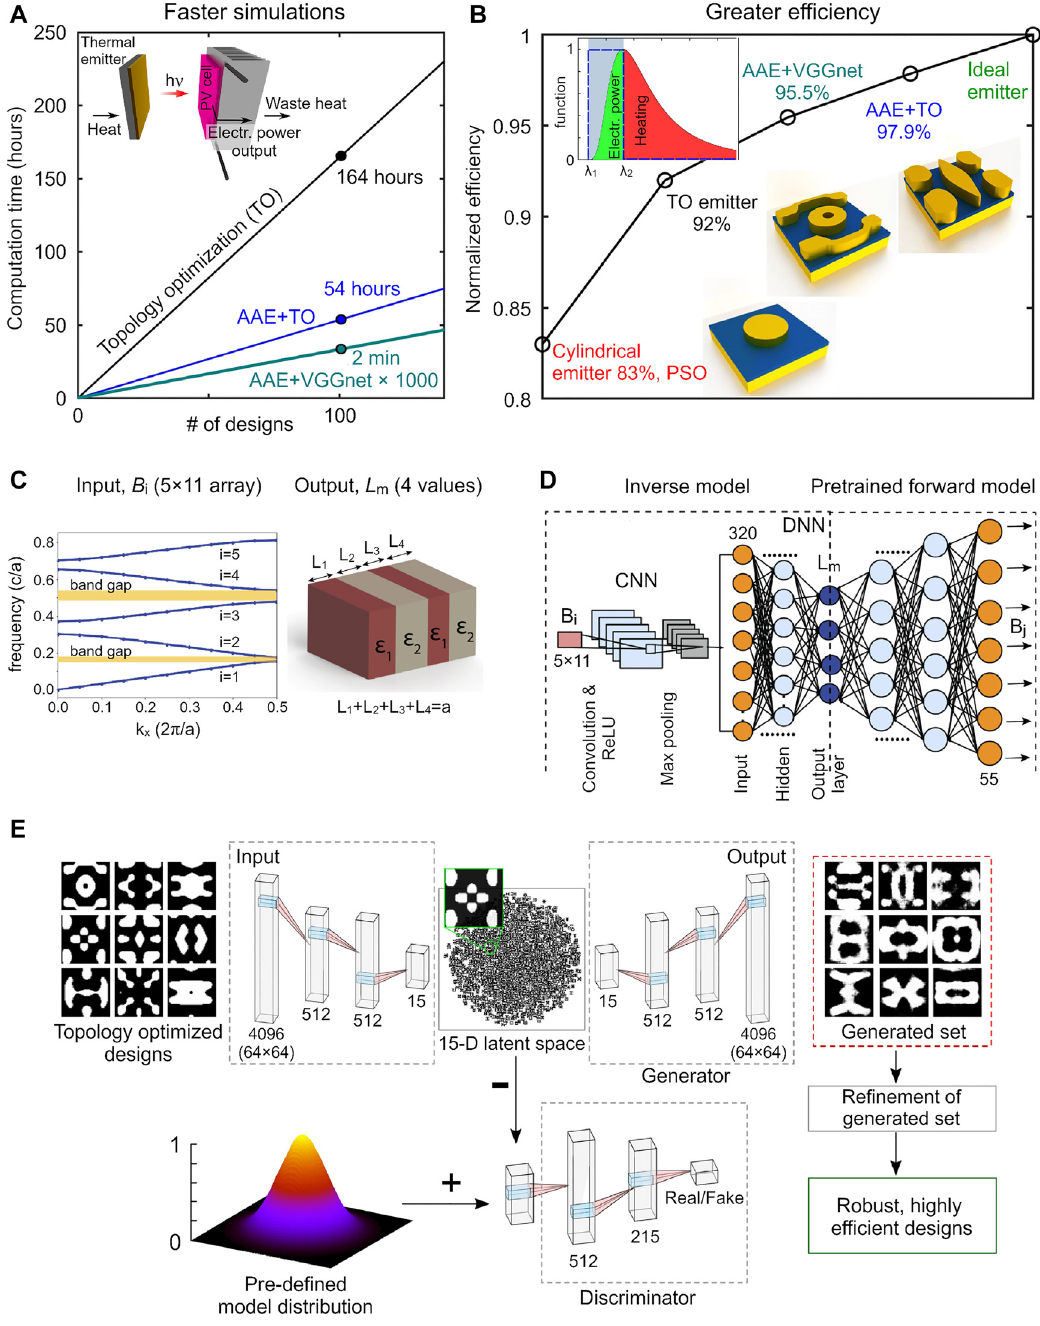
Figure 3: Inverse design of photonic devices by neural networks. A , B Advantages of neural networks with respect to some conventional simulation methods, namely topology optimization (TO), and particle swarm optimization (PSO). TO is used to generate the training set. TO and adversarial autoencoder (AAE) are compared in the inverse design of the metasurface thermal emitter. TO and CNN VGGnet are employed for structure refinement. A Computational time versus number of highly efficient designs. Inset: Schematics of the thermophotovoltaic engine. B Efficiencies for the best designs obtained via different simulation methods. Left inset: Normalized spectrum of the black-body radiation; the grey region highlights the photovoltaic cell working band; only the in-band radiation is transformed into electrical power; the blue line depicts the ideal emitter emissivity. Right insets: Finest meta-atom patterns. C , D Inverse design of a photonic crystal slab. C Band structure (left) used for the inverse design of the 1D photonic crystal slab (right). D Architecture of the neural networks implemented in the inverse design. E Generative model handling the inverse design of the metasurface thermal emitter. Panels A, B, E are adapted with permission from Ref. [73] (Copyright 2020 American Institute of Physics), and panels C, D from Ref. [77] (Copyright 2020 Optical Society of